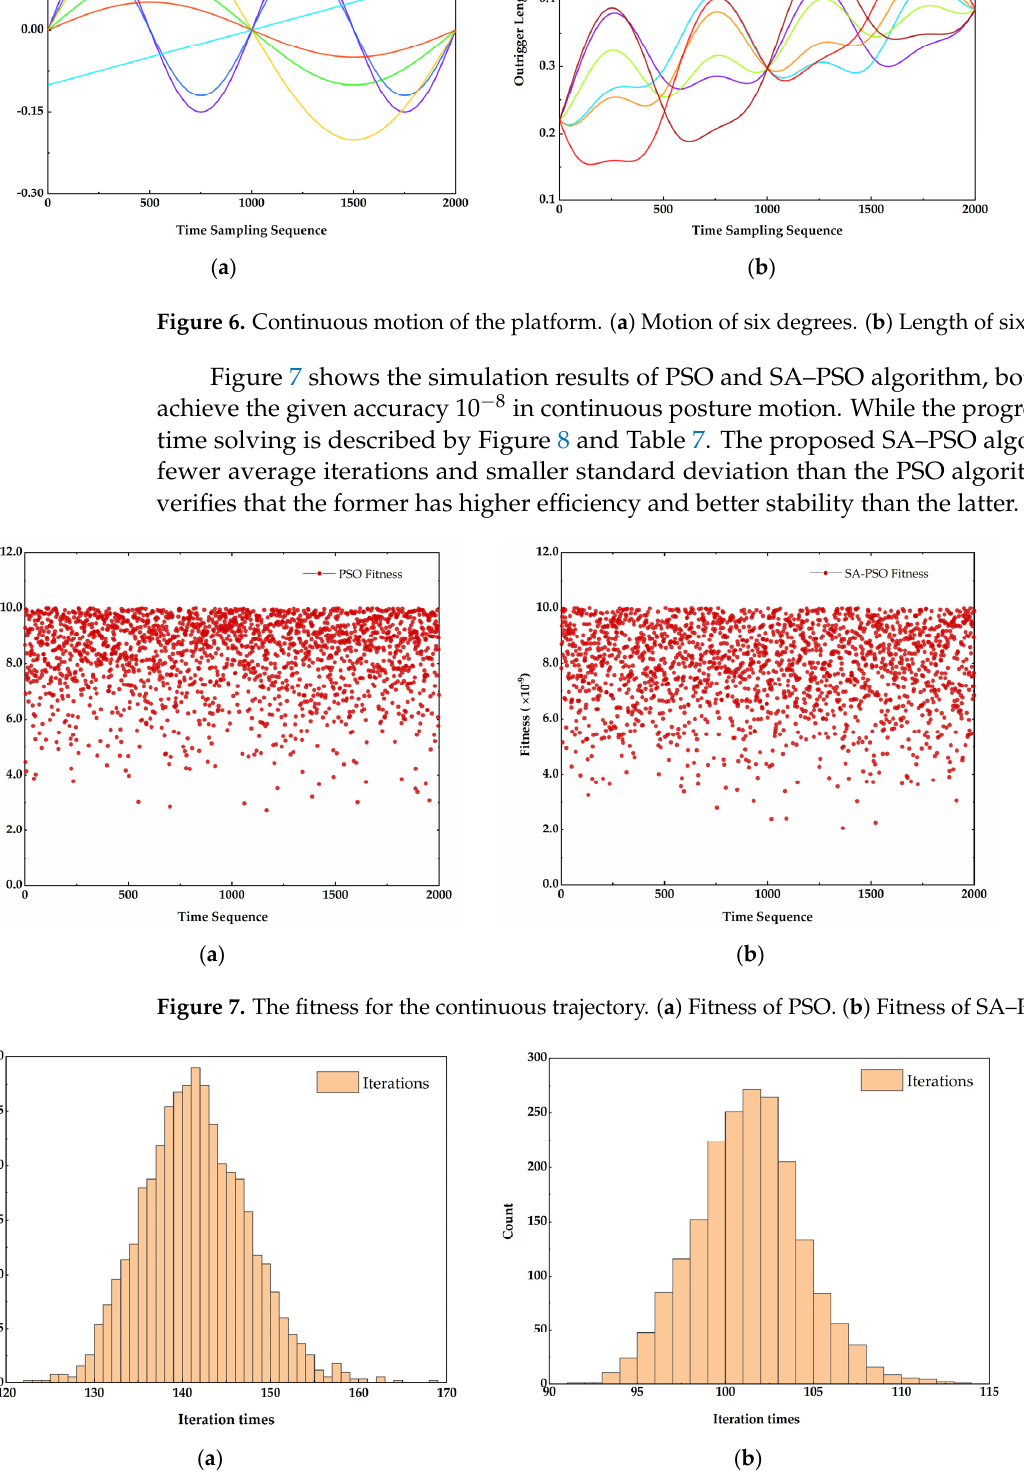
Figure 8. The histogram of iterations for the continuous trajectory. ( a ) Iterations of PSO. ( b ) Iterations of SA–PSO. Table 7. The comparison between PSO and SA–PSO in iterations.